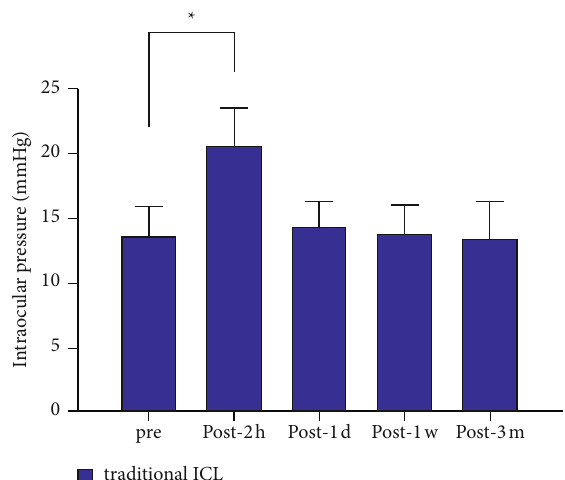
Figure 4: Time course of IOP changes in eyes undergoing tradi- tional ICL implantation. ∗ P < 0 . 001.